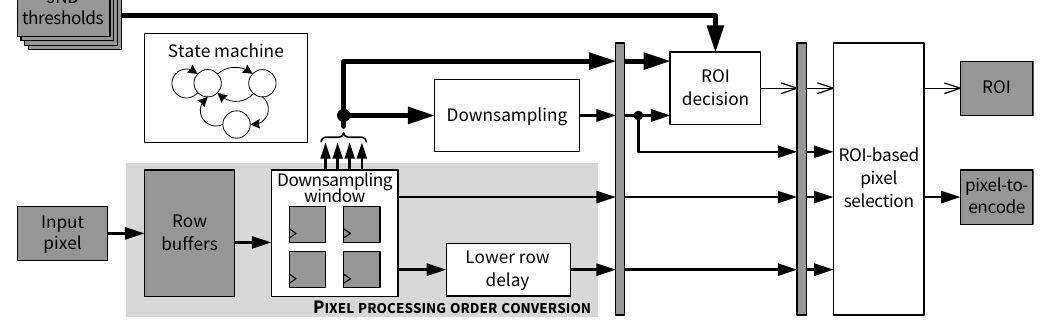
Figure 19. Encoder front end